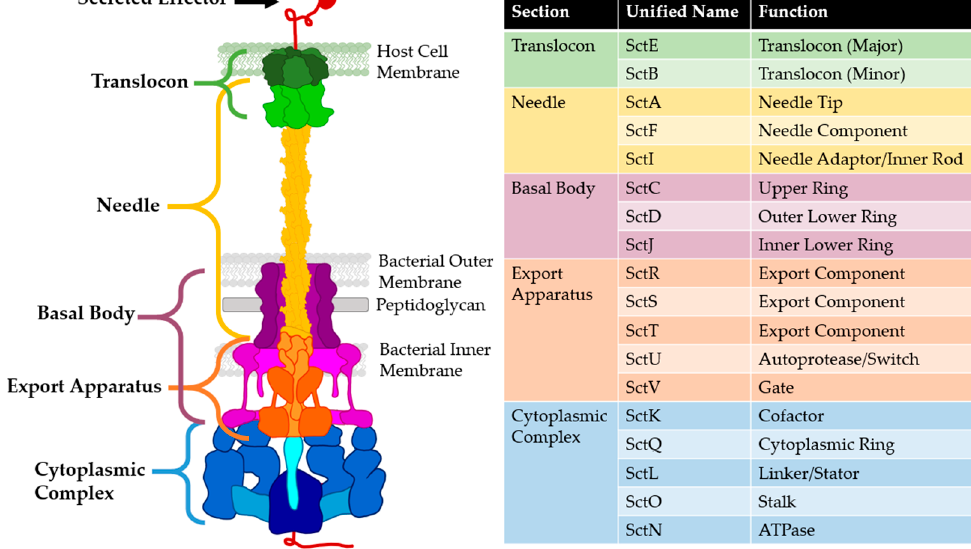
Figure 1. The general structure of the T3SS. Left : Cross-section of a prototypical T3SS with color-coded and labeled sections. Right : Table of unified names of T3SS structural components by section [23].